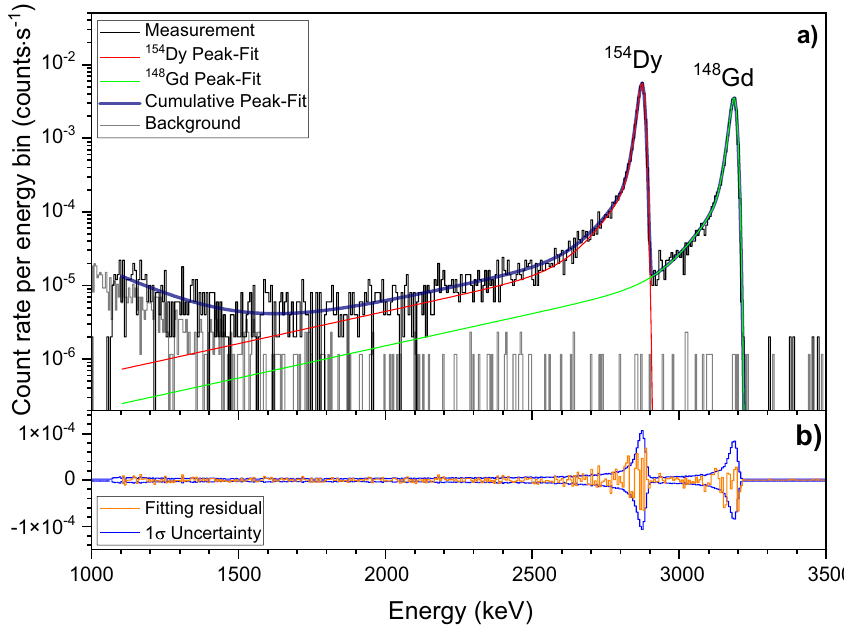
Figure 3. ( a ) α-spectra (black line) of the electrodeposited Dy on a graphite foil (SDD = 10.4 mm, counting time = 5∙10 5 s or 5.8 days). The histogram bin size is 5.925 keV. The presence of 148 Gd, contained in traces in the Dy separated fraction (isotope ratio 154 Dy: 148 Gd ≈ 28,000:1), is clearly visible. The model (navy line) that comprises the fit of the 154 Dy peak (red line), the 148 Gd peak (green line), as well as the electronic low energy noise, is shown. In addition, the background (light grey line) recorded during a period of 10 days (8.64∙10 5 s) is superimposed. ( b ) Fitting residuals. The residuals (orange line) are consistent with the Poisson counting statistics of the spectrum (1σ uncertainty, blue line).